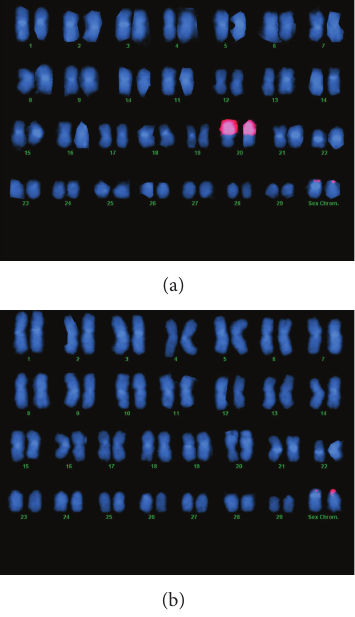
Figure 2: (a) Hybridization of the BAC clone RE143K08 (which is found near the 3 󸀠 end of the OmyY1 contig and contains the OmyY1 marker, the sdY gene and ribosomal DNA) to male rainbow trout chromosomes. Note the signals on the sex chromosome pair and chromosomepair20,thesiteofthe18SrDNAlocusinrainbowtrout. (b) Hybridization of the BAC clone RT429A21 to male rainbow trout chromosomes. This BAC is close to the 5 󸀠 end of the OmyY1 contig (6256) (see Figure 1). Note the larger signal on the Y chromosome compared to the